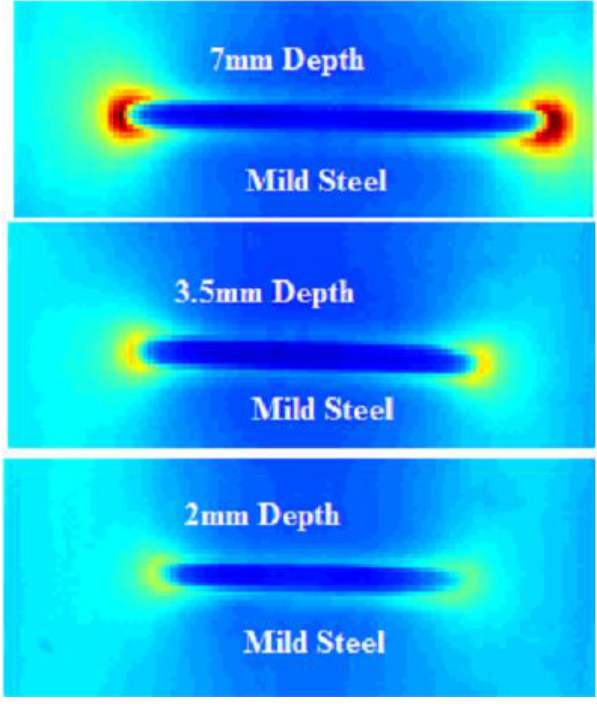
Figure 8. Pulsed eddy current (PEC) thermography image of a steel sample with different defects (Reproduced from [19] with permission). The sample is 40 mm × 30 mm × 10 mm, and the defects are, respectively, 15 mm × 2 mm × 7 mm, 10 mm × 2 mm × 3.5 mm, 10 mm × 2 mm × 2